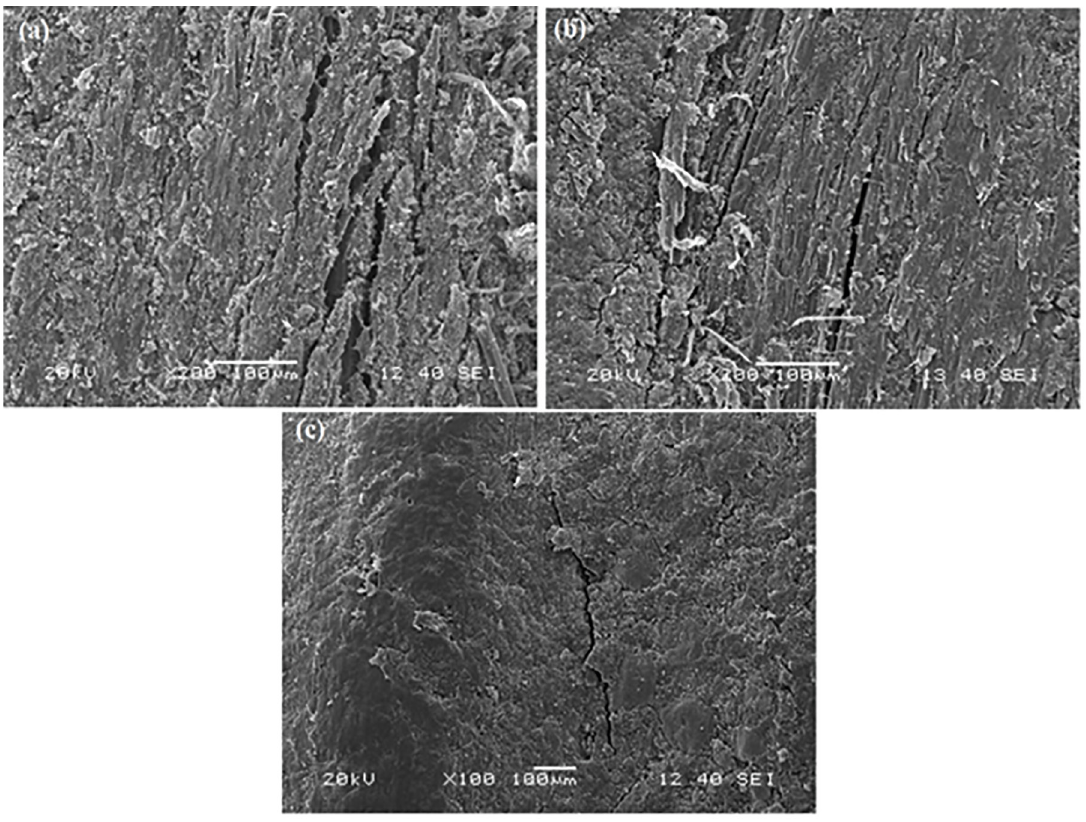
Figure 5. SEM images of (a) Untreated (b) Alkali treated and (c) Benzoyl chloride treated composite surfaces after three body abrasion at 30 wt.% of fiber loading subjected to Normal load of 10